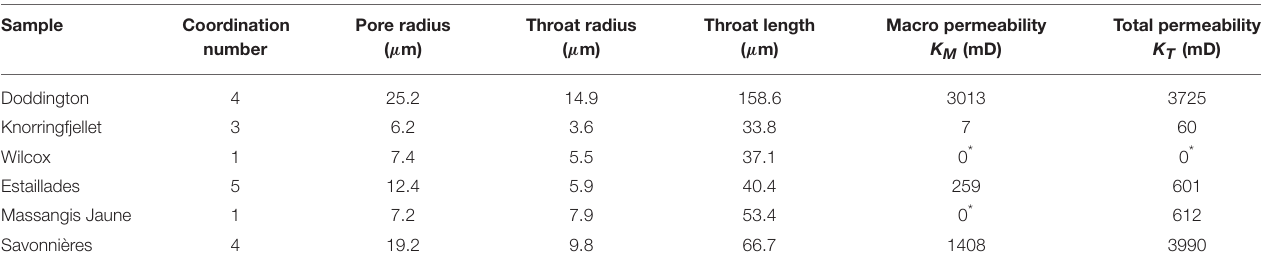
Showing mean values of coordination number, and median pore radius, throat radius, and throat length. * Zero connected porosity to perform permeability simulation.